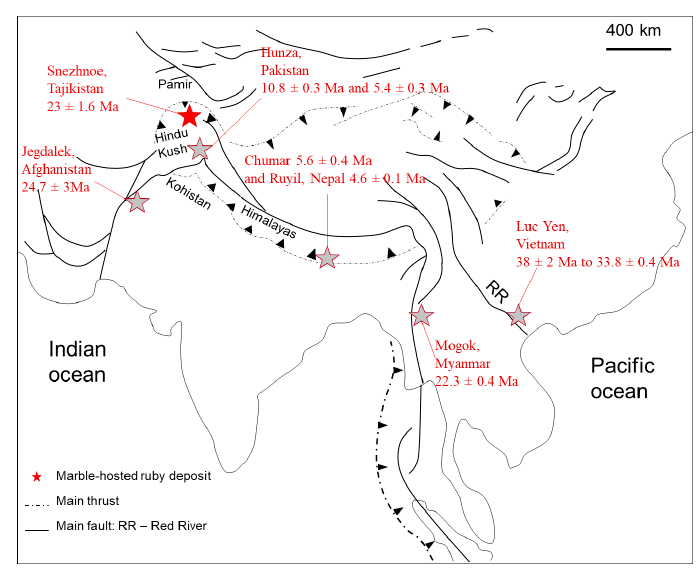
Figure 16. Tectonic map of Central and South East Asia with location of marble-hosted gem corundum deposits shown as gray stars (modified after [54]). Red star indicates the Snezhnoe ruby deposit with Rb–Sr age obtained in this study. The ages of ruby deposits are from [2] and [53].